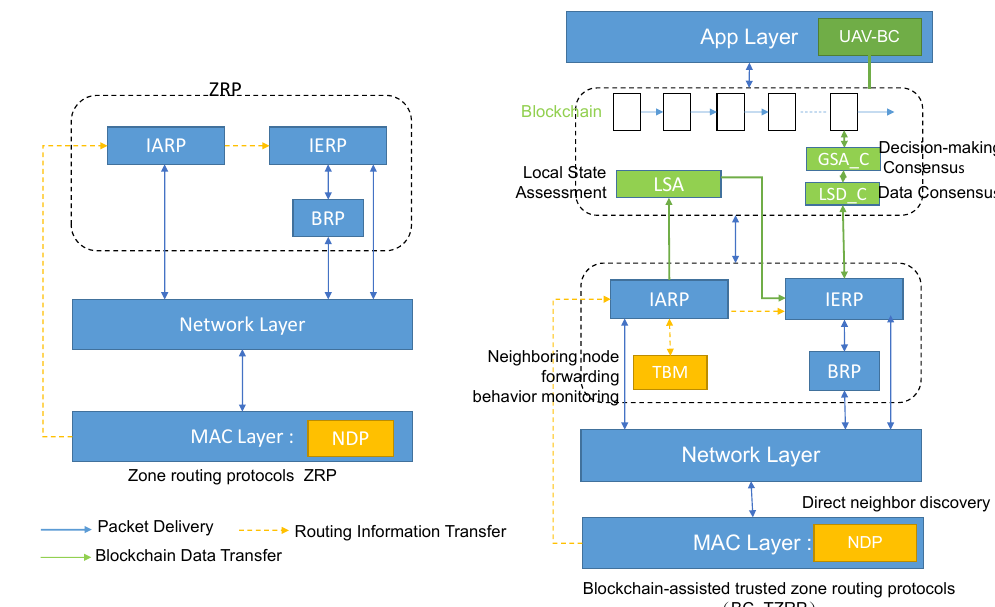
Figure 2. Mission-Oriented UAV Network Blockchain